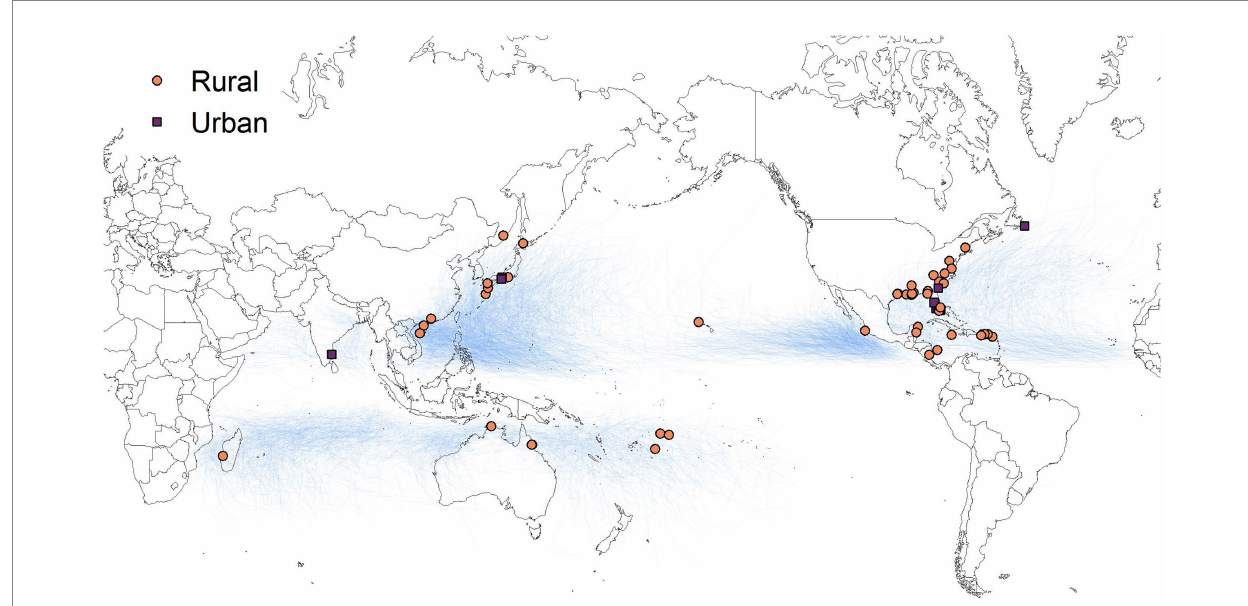
FIGURE 1 Tracks of tropical cyclones which have made landfall since 1970 (light blue lines) and the location of urban and rural studies (purple squares and orange circles, respectively) selected for inclusion in the literature review. Hurricane track data from Knapp et al. (2010,